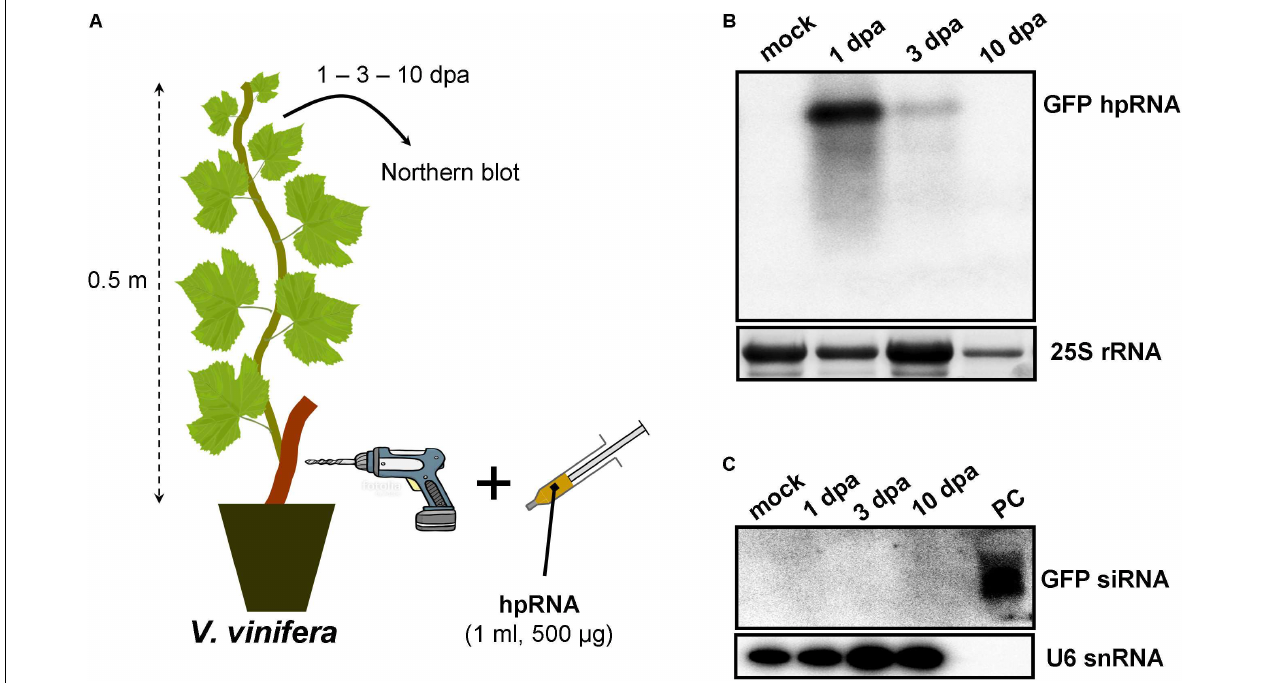
FIGURE 2 | Delivery of exogenous hpRNA (500 nt) in V. vinifera by trunk drilling. (A) Apical leaves were harvested 1, 3, and 10 dpa and total RNA was extracted. (B) Northern blot for the detection of GFP hpRNA. Total RNA (5 µ g) was analyzed in a 1.2% agarose/formaldehyde gel and the full-length GFP cDNA fragment (792 bp) was used as a hybridization probe. The ethidium bromide stained gel depicts the 25S rRNA band and serves as an RNA loading control. (C) Northern blot for the detection of GFP siRNAs. Total RNA (20 µ g) was analyzed in a 15% polyacrylamide gel and the full-length GFP cDNA fragment (792 bp) was used as a hybridization probe. As positive control (PC) in vitro synthesized 22-nt GFP siRNAs (100 ng) were included. Hybridization of the membrane with a DNA oligo detecting the U6 snRNA served as an RNA loading control.